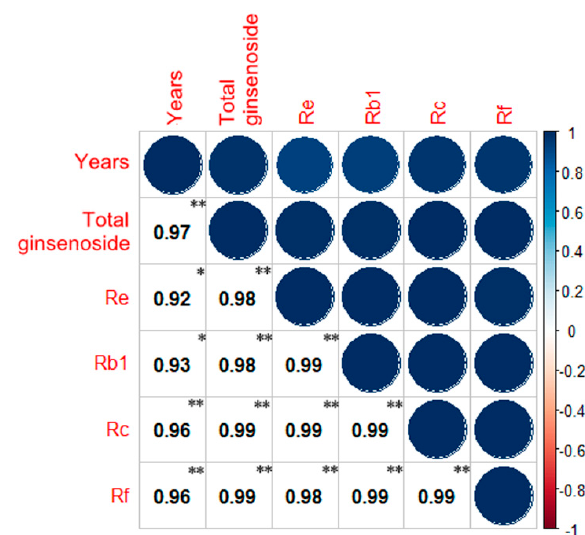
Figure 6. The correlation analysis of total ginsenoside and individual ginsenosides. (** The correlation is significant, with a confidence level (double test) of 0.01. * The correlation is significant, with a confidence level (double test) of 0.05.)